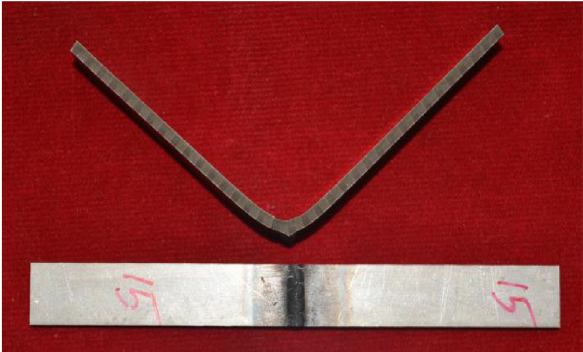
Figure 11: Schematic diagram of the bending specimen before and after